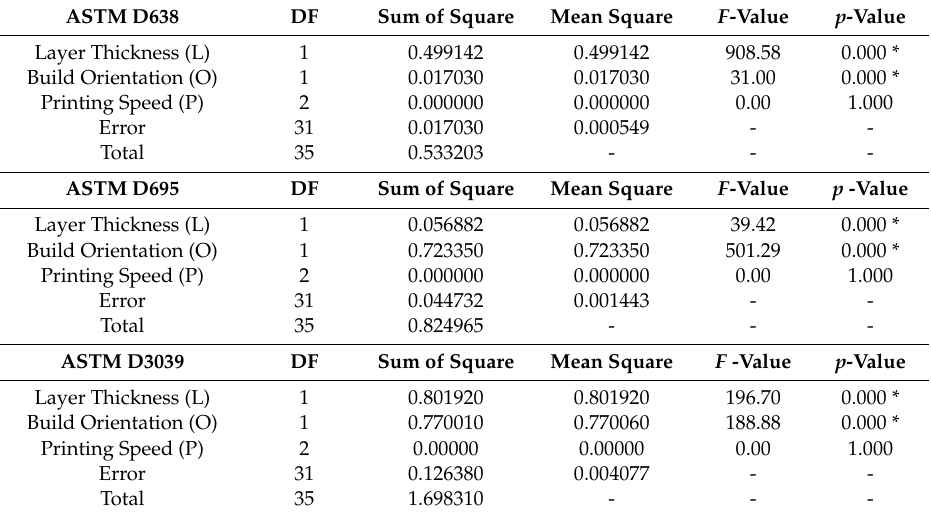
Table 10. ANOVA results for the material cost (* α <